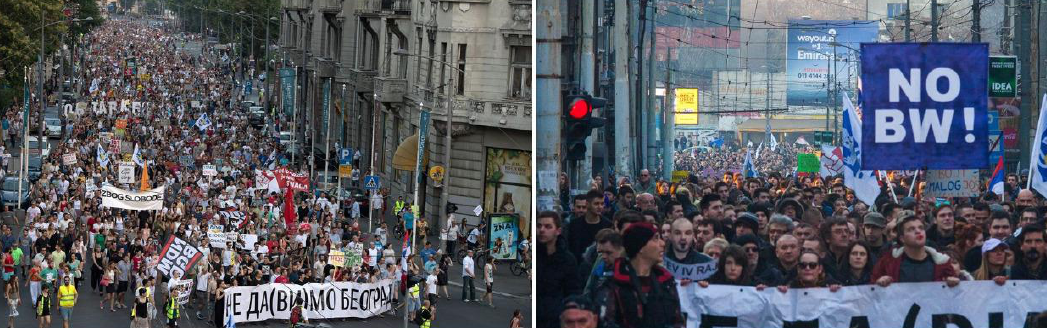
Figure 6. Protests organized by the Don’t let Belgrade D(r)own organization on 13 June 2016 and 15 February 2017. The first protest was organized on 11 May 2016, and the protests that followed gathered thousands of people dissatisfied with the demolition in Savamala. After the activism was triggered by development in Savamala, this organization started to pay attention to different urban and social issues, and began political involvement taking place in progressive left side of the political spectrum (source: Facebook page Ne da(vi)mo Beograd).